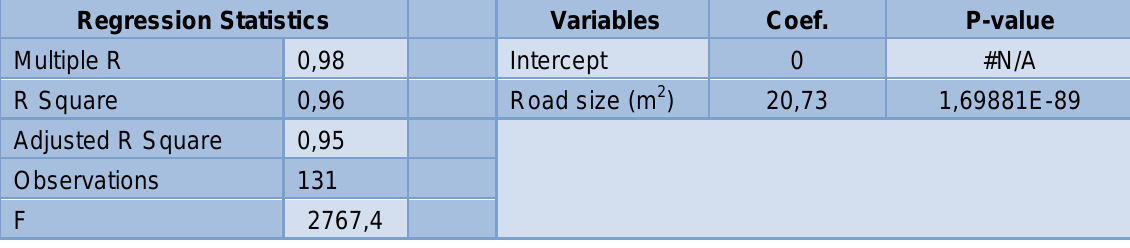
Table 17 Multiple regression results among total project cost and road size Equations that describe the cost of the major road construction activities as a function of road length and width are developed. The best fit models are achieved when variables interaction is used and intercept value = 0. The results are shown in Table 18. The Table shows that r2 values are high. This indicates a good relationship between dependent and independent variables.